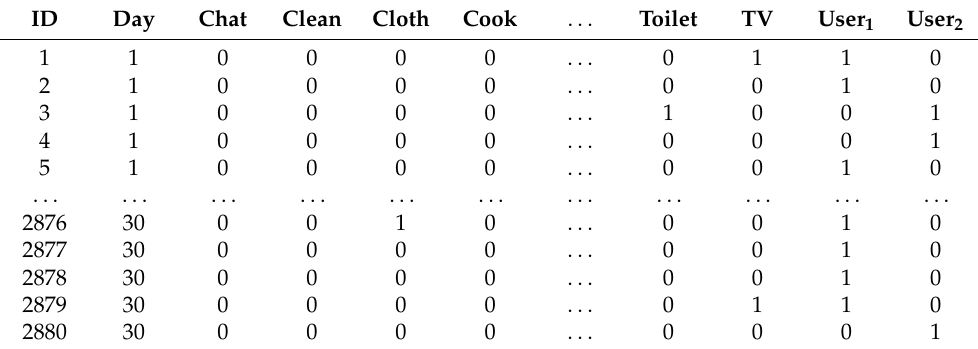
Table 8. Results of one-hot encoding.